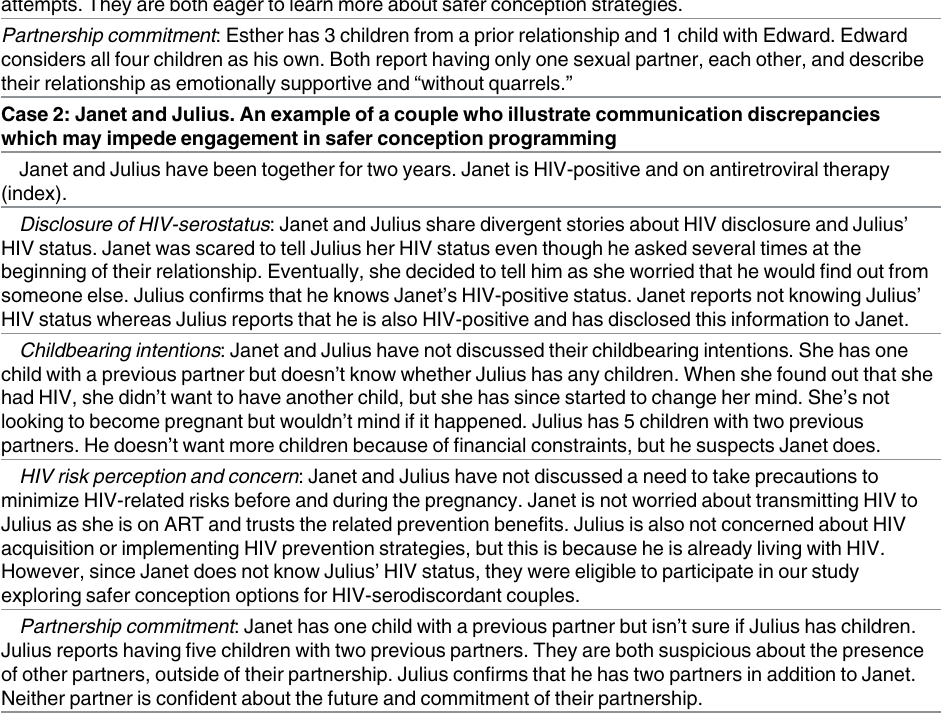
Table 2. Case studies (using pseudonyms) createdfrom interviews with each member of the couple. Case 1: Esther and Edward. An example of a couple that is well-primed to engage in safer conception care Esther and Edward have been together for over two years. Esther is HIV-positive and on antiretroviral therapy (index), while Edward is HIV-negative (partner). Disclosure of HIV-serostatus : Esther disclosed her HIV-serostatus to Edward at the beginningof their relationship. She knows that Edward is HIV-negative and he undergoes regular HIV testing to confirm his HIV-negative status. Edward is confused by the fact that he is still HIV-negative despite being with Esther for several years. He explains their HIV-serodiscordant status as being due to his “strong blood” and her adherence to